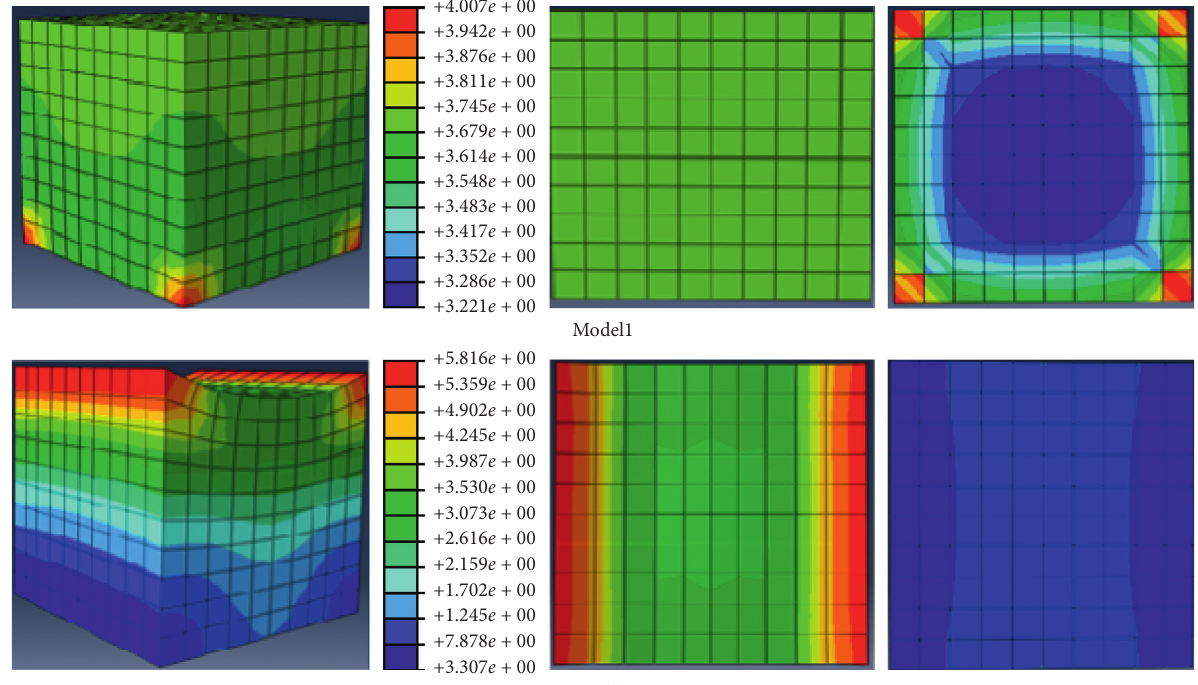
Figure 6: Results of the mathematical modeling for REF116